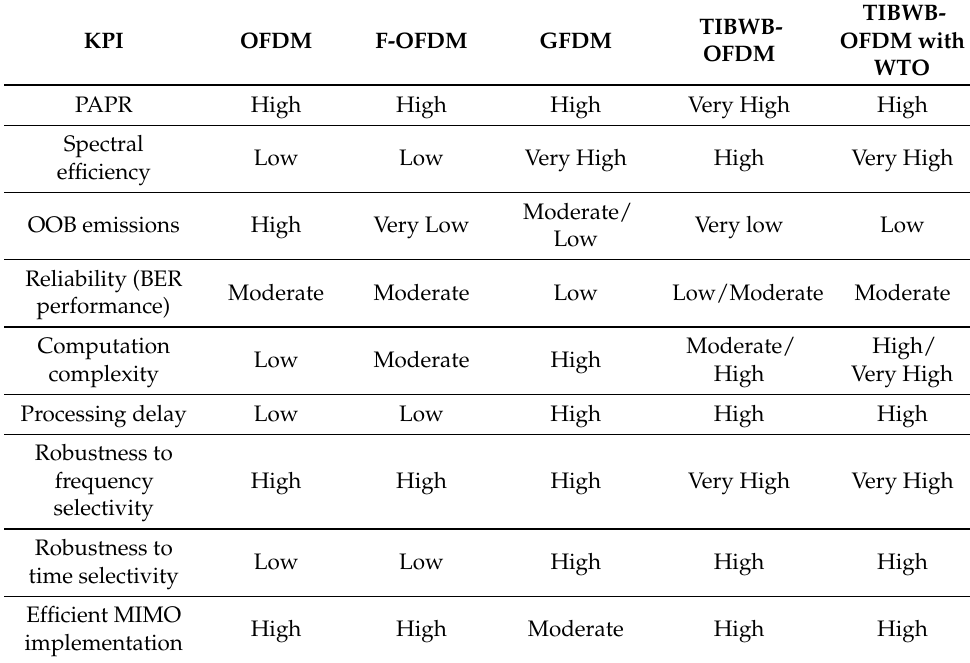
Table 3. Comparison of different MC